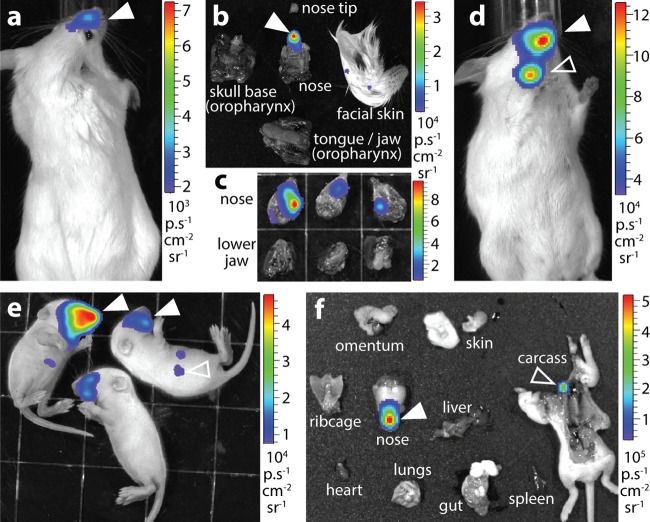
Adult mice also show nasal MCMV host entry. (a) Live image of an adult BALB/c mouse 4 days after i.n. MCMV-LUC (105 PFU). The image shown is representative of the images for eight mice. (b) Ex vivo imaging confirmed nasal infection (filled arrow) and not oropharyngeal infection. The images shown are representative of the images for eight mice. (c) Ex vivo imaging of C57BL/6 mice 4 days after i.n. MCMV-LUC (105 PFU) showed nasal and not oropharyngeal signals. The images shown are representative of the images for six mice. (d) Live image of an adult BALB/c mouse 4 days after i.n. M78-LUC MCMV (105 PFU), showing nasal (filled arrowhead) and cervical lymph node (open arrowhead) signals. The image shown is representative of the images for six mice. (e) Live imaging of BALB/c pups 2 days after i.n. M78-LUC (3 × 104 PFU) showing nasal signals (filled arrowheads) and background liver signals (open arrowhead). The image shown is representative of the images for 12 mice. (f) Ex vivo imaging of a representative BALB/c pup (n = 12) 2 days after i.n. M78-LUC (3 × 104 PFU) showing a strong nasal signal (filled arrowhead) and a weak cervical lymph node signal (open arrowhead). The images shown are representative of the images for six mice.